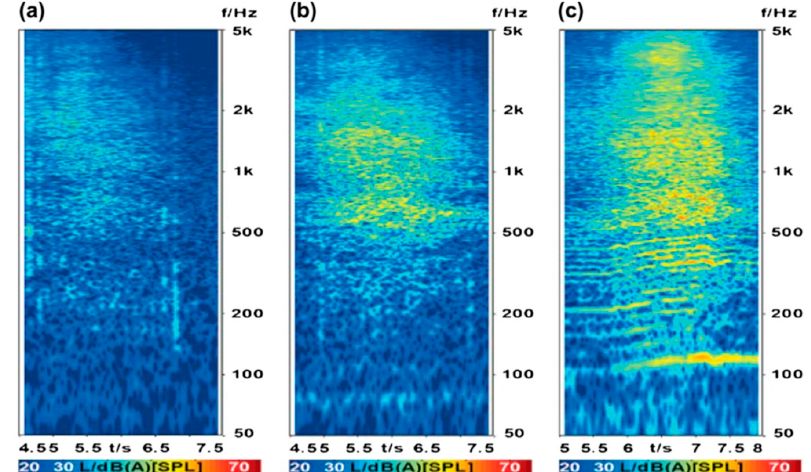
Figure 17. Colourmap plots of different pass-by noise tests: ( a ) engine switched off and slick tires; ( b ) engine switched off with standard tires; ( c ) ISO 362 acceleration test (source from Braun et al., 2013 [155], Figure 7; original from Alt et al., 2006, [154]; reprinted with permission from Elsevier).